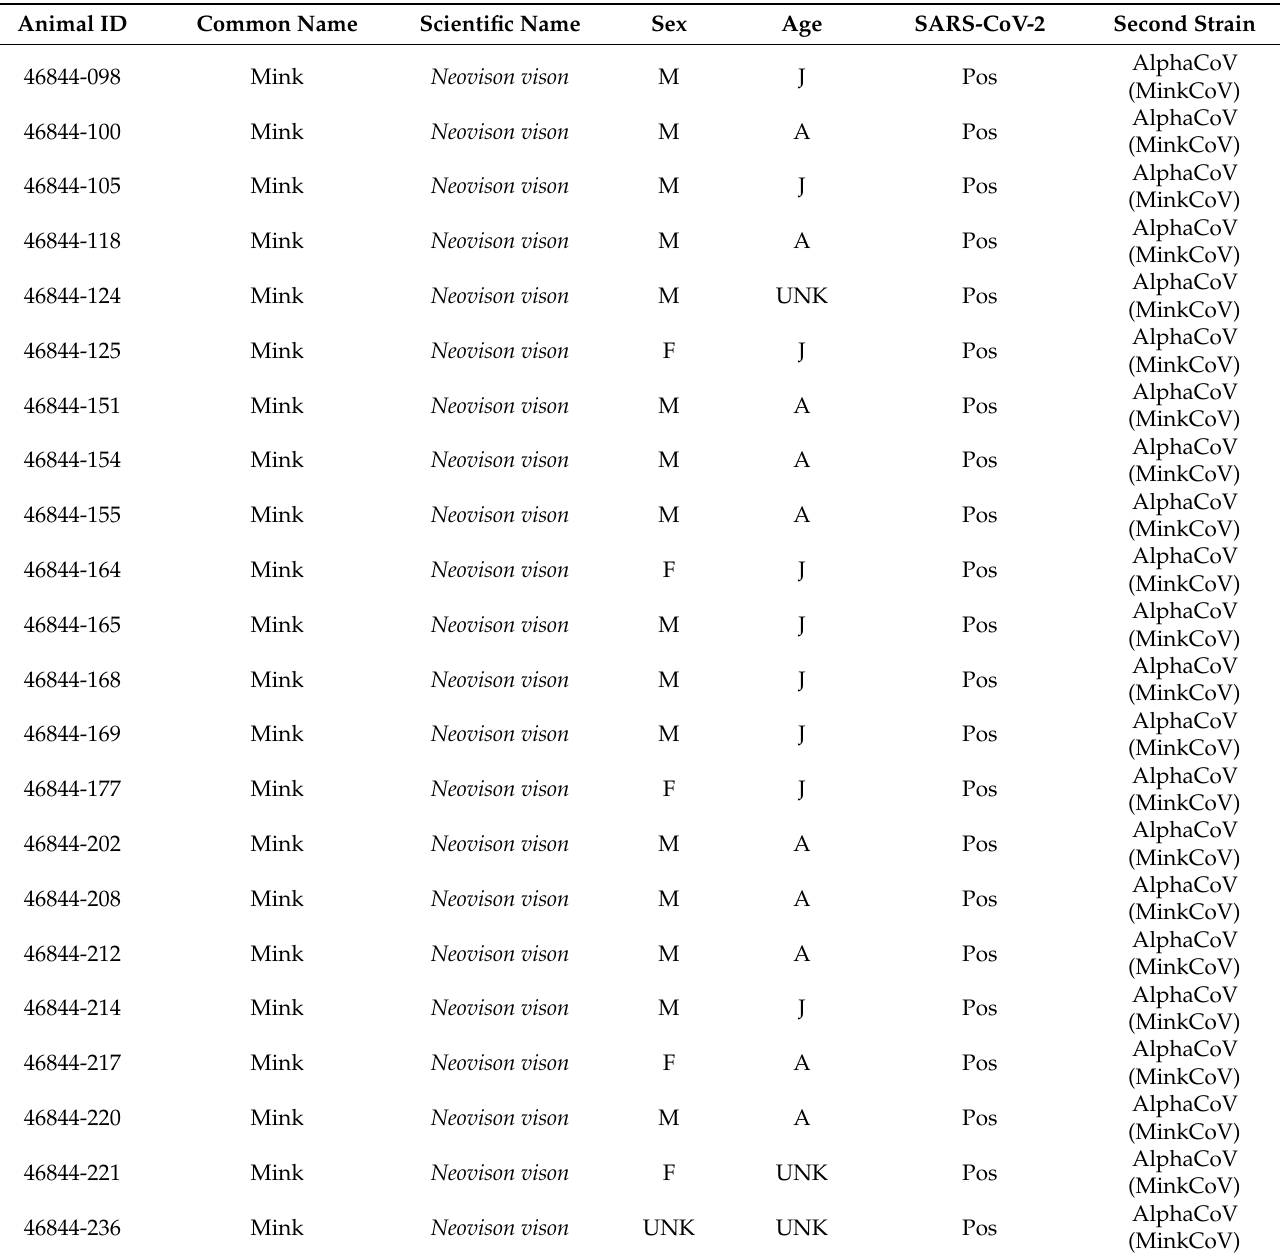
Table 4. SARS-CoV-2 coinfections identified in Utah mammals. The individual animals that are both SARS-CoV-2 positive and infected with a second coronavirus are listed. Animal ID, Unique animal identification number; Common name, common name of animal; Scientific name, scientific name of animal; Sex, F, female, M, male. Unk, unknown; Age, A adult, J juvenile, Unk, unknown; SARS-CoV-2, Neg-N1 RT-PCR negative, Pos-N1 RT-PCR positive, Second strain, genus and common name of the coronavirus, Pan-CoV RT-PCR Equivocal, sample is PCR positive but not further